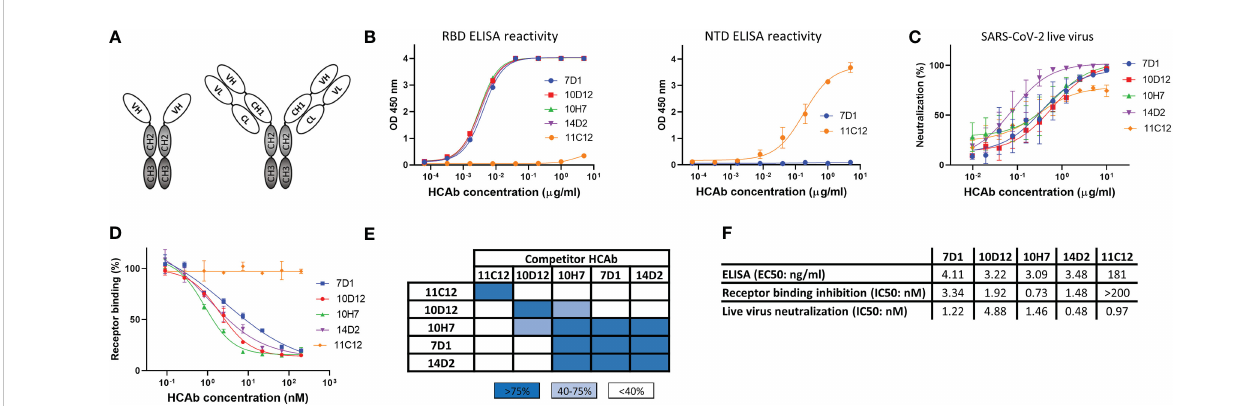
FIGURE 1 Human heavy-chain-only antibodies with SARS-CoV-2 neutralizing activity. (A) Schematic representation of a human heavy-chain-only antibody (HCAb) and a conventional IgG antibody; VH, variable heavy chain domain; VL, variable light chain domain; CL, constant light chain domain; CH1-CH3, constant heavy chain domains. CH2 and CH3 domains that comprise the Fc region are depicted in grey. (B) ELISA-reactivity of HCAbs to the receptor binding domain (RBD, left panel) and N-terminal domain (NTD, right panel) of the SARS-CoV-2 S protein. (C) Neutralization of SARS-CoV-2 by HCAbs in Calu-3 cells. (D) ACE2-receptor binding of the SARS-CoV-2 S ectodomain trimer was preincubated with each of the serially diluted HCAbs. Error bars indicate SD between at least two independent replicates. (E) Heatmap showing binding competition of HCAbs to the SARS-CoV-2 S ectodomain, as determined by biolayer interferometry. Results are classi fi ed using color shading codes with a percentage of inhibition ≥ 75% in blue, <75% but ≥ 40% in light blue, and no shading for a percentage of inhibition <40%. BLI sensorgrams showing the HCAb binding competition pro fi les are shown in Supplementary Figure 1A. Binding competition experiment was performed twice independently, data from one representative experiment are shown. (F) Antibody titers for ELISA- based binding, receptor binding inhibition and neutralizing potency of SARS-CoV-2 S-directed HCAbs were calculated based on inhibition curves shown in (B, D, C)